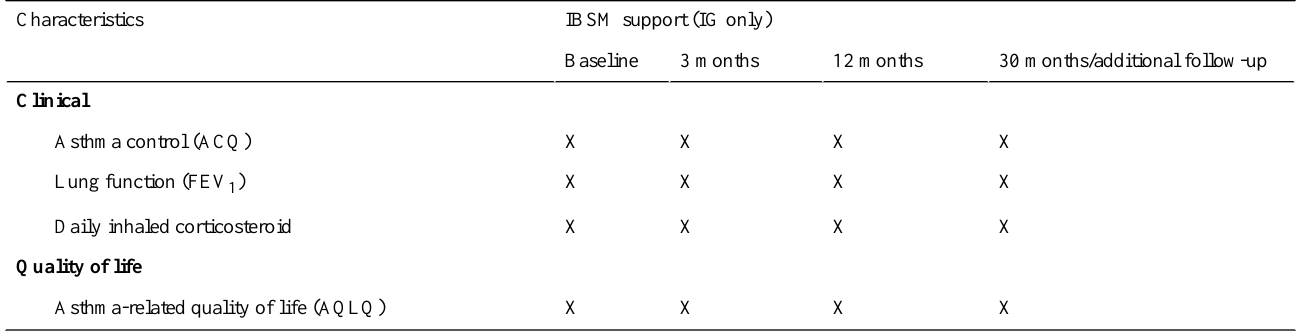
Table 2. Outcome measures.